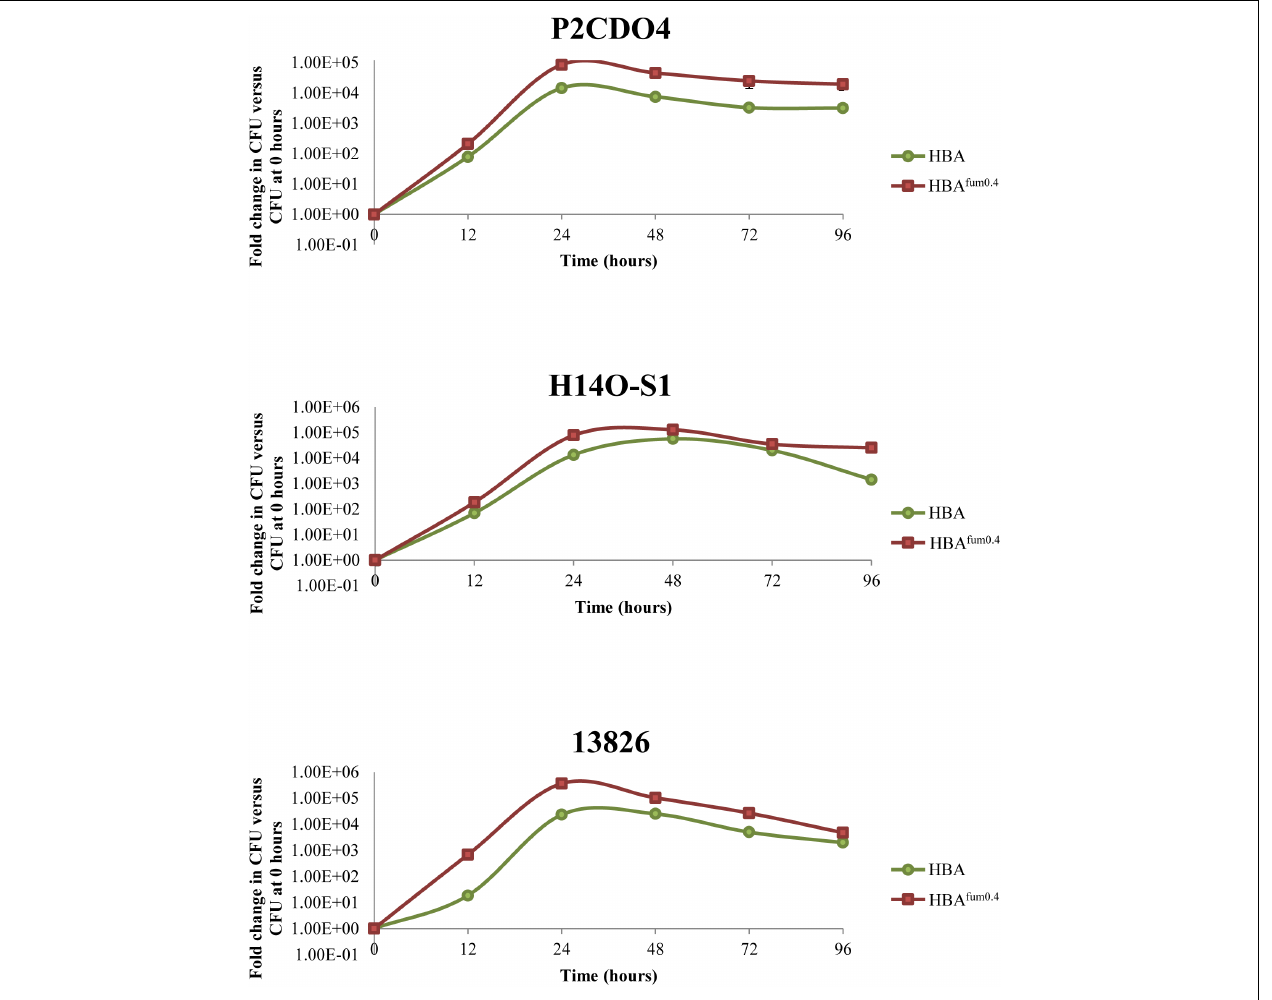
FIGURE 6 | Growth of C. concisus strains P2CDO4, H14O-S1, and 13826 cultured on HBA fum0 . 4 and HBA over 96 h. A. Each strain was cultured on HBA and HBA with 0.4% sodium fumarate (HBA fum0 . 4 ) and the total bacteria were enumerated at 0, 12, 24, 48, 72, and 96 h after incubation. Results are represented as a CFU fold change relative to the CFU at 0 h of incubation from quadruplicate